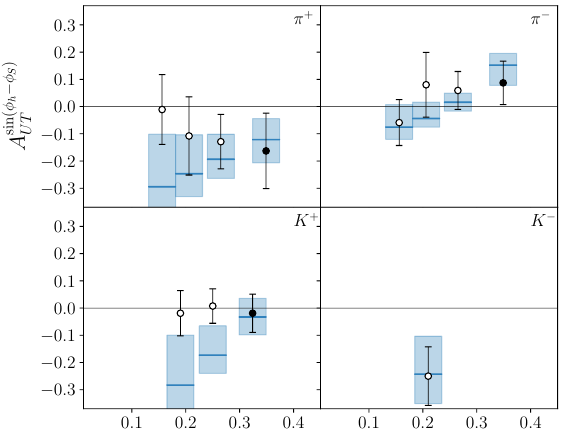
Figure 8. Description of JLab HALL A data [41, 42] for π ± and K ± . Solid (open) symbols data used (not used) in the fit. Blue line is the CF and the blue box is 68%CI of the fit of the data and prediction for the data not used in the